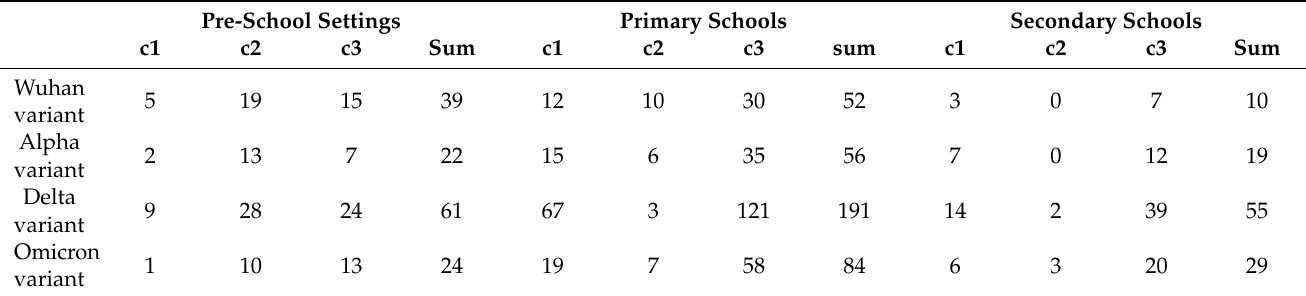
Table 5. Representation of the fulfilled COVID-19 outbreak criteria in educational settings in Slovenia in the period from 26 January 2021 to 18 January 2022, taking into account the periods of predominance of each SARS-CoV-2 variant in Slovenia.